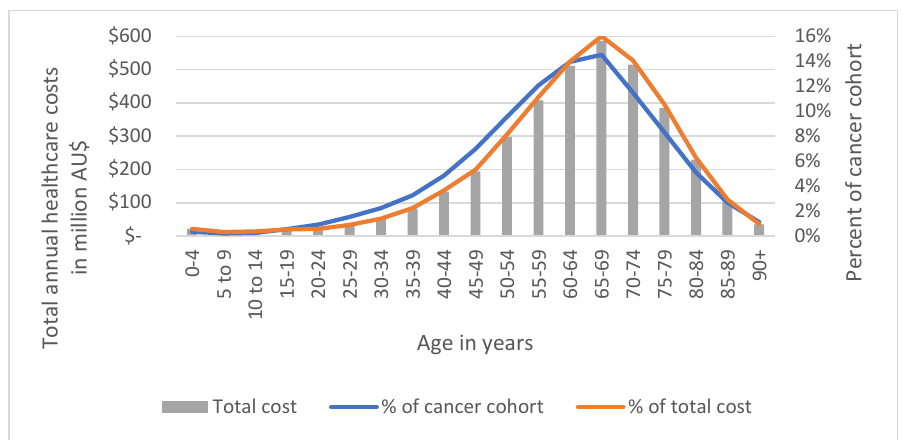
Figure 7. Total annual healthcare costs (2013–2016) in AU$ by age group and proportion of cancer cohort (N = 230,380).